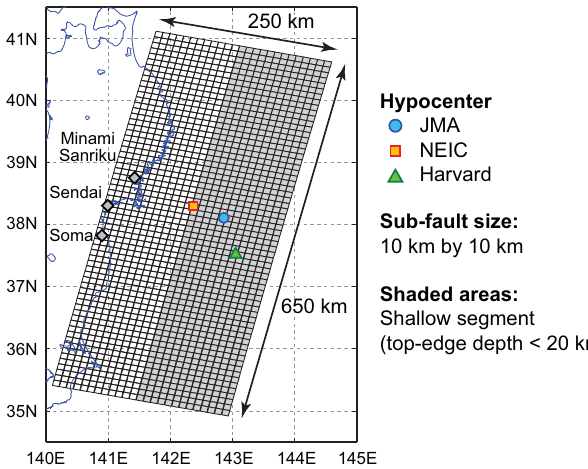
Figure 2. Tsunami source region off the Tohoku coast of